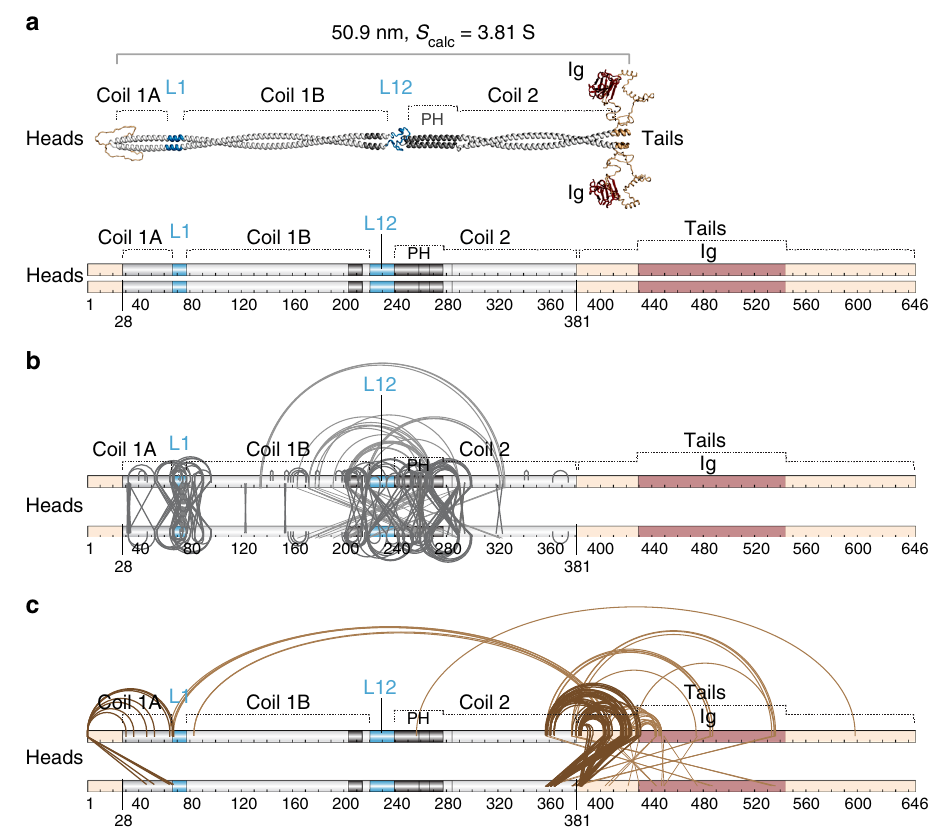
Fig. 5 Distribution of intra-dimeric cross-links between lamin A dimer domains. a Lamin A schematics showing predicted structural organisation (top) and linear domains (bottom). Labels indicate predicted coiled coils (1A, 1B and 2 with PH parallel hendecad region; heptads light grey and hendecads dark grey) and linkers (blue – α -helical L1, unstructured L12). b , c Positions of all unique intra-dimeric cross-links identi fi ed (Supplementary Table 1) within the rod domain ( b ) or within the head and tail domains and between these domains and the rod domain ( c ). Cross-links within the rod appear to cluster